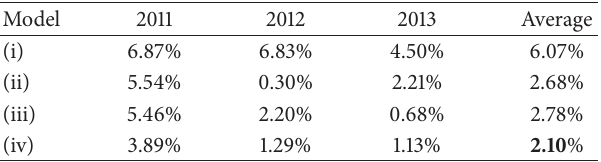
Table 4: Errors of hypothetical forecast in 2011–2013 based on prior data.